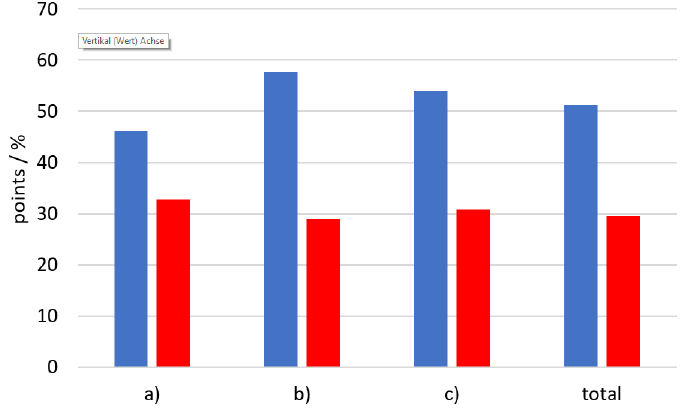
Fig. 12. Results in an exam (N=39). Blue: VR-group, Red: control group: Average points achieved in subtasks and total